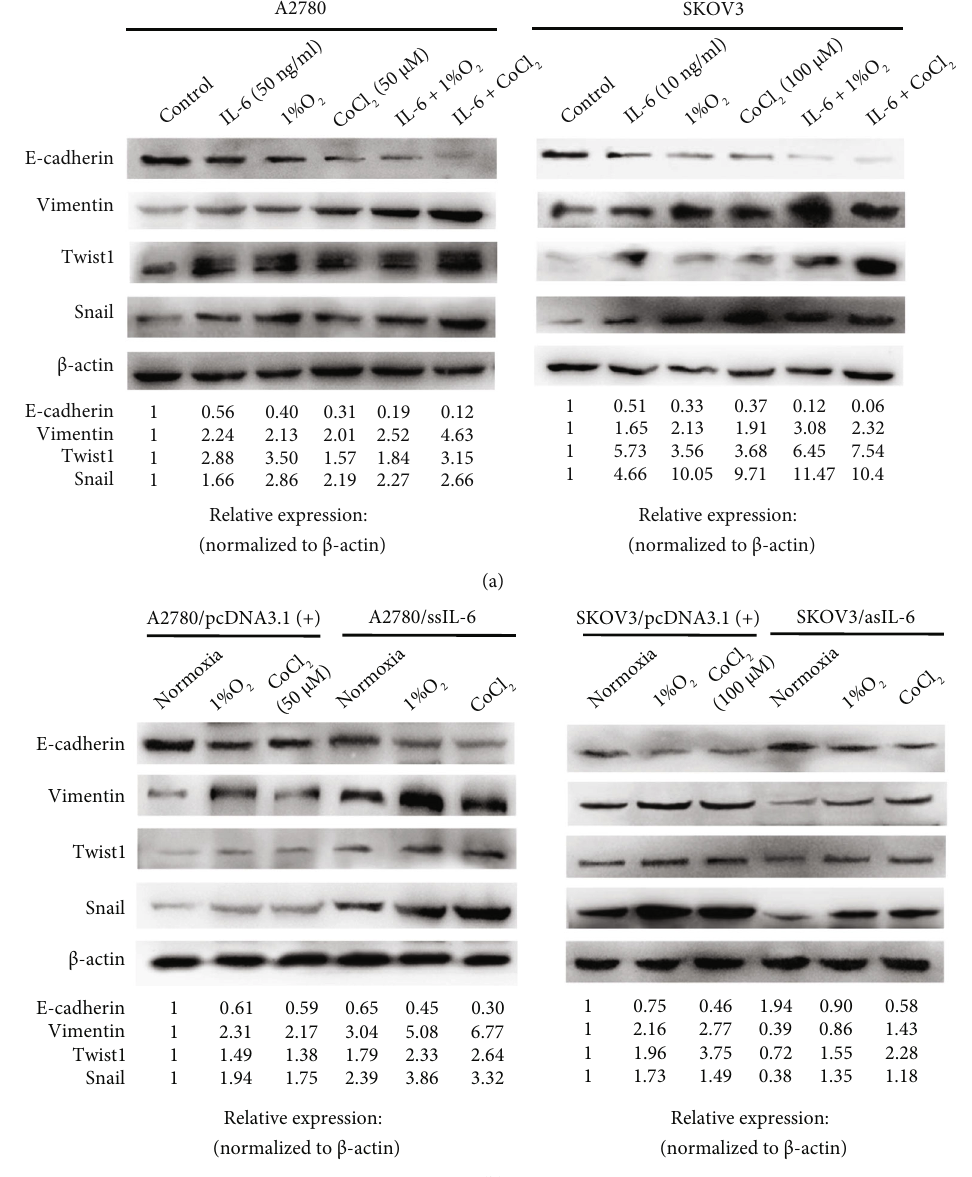
Figure 3: Exogenous and endogenous IL-6 combined with hypoxia regulates the protein expression of EMT markers in EOC cell lines. (a) A2780 and SKOV3 cells were treated with or without IL-6 as described in Figure 1 under normoxic (21% O conditions, respectively. After treatment, the protein levels of EMT markers were analyzed by western blotting. (b) A2780 clones overexpressing IL-6 and SKOV3 clones with depletion of IL-6 were treated under normoxic (21% O conditions as described for (a), respectively. After treatment, the protein levels of EMT markers were analyzed by western blotting. Representative images from three independent experiments are